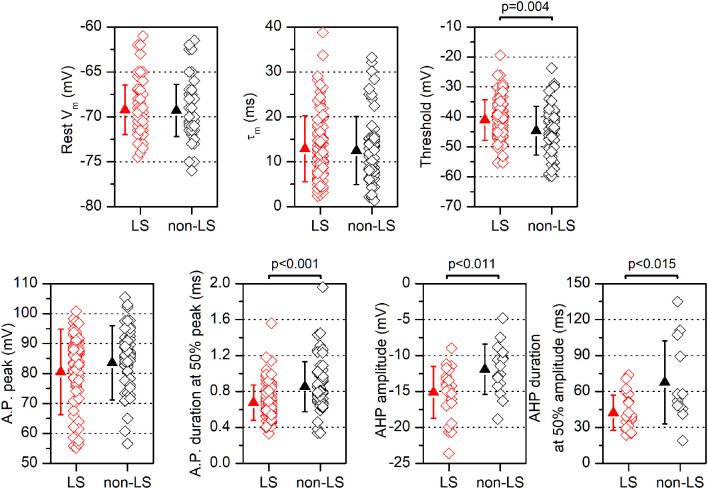
Electrophysiological parameters are measured in LS and non-LS neurons. Each panel shows the values obtained from individual neurons (diamonds) and the mean ± s.d. (triangles) of several parameters measured in LS neurons and non-LS neurons. The resting membrane potential (Vm) was measured immediately after entering into the whole-cell mode; the threshold was measured at the 1st action potential in a just-threshold response; the action potential duration was measured at half amplitude; the peak amplitude of the action potential after-hyperpolarization (AHP) was measured from the threshold level, and the AHP duration was measured from the peak to 50% of the peak amplitude.